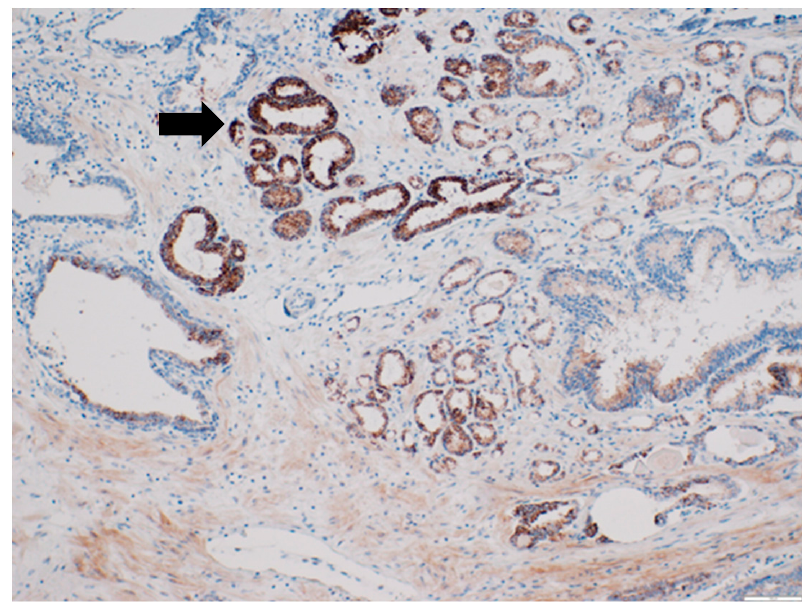
Figure 2. Representative photomicrograph of CD63 expression in high-grade prostate cancer. The black arrow indicates CD63 protein expression. Immunohistochemical staining method; magnifica- tion ×200; scale bar 100 µm.